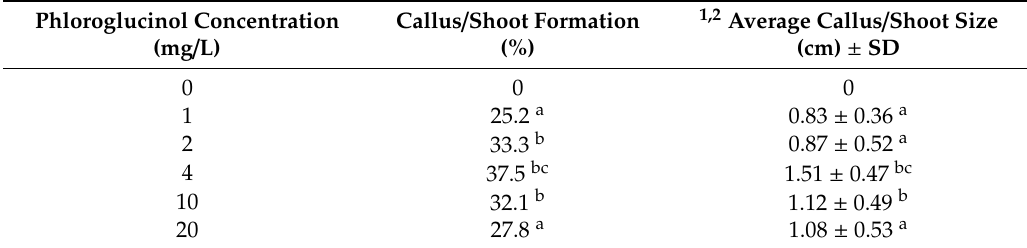
Table 2. Phloroglucinol e ff ects on tissue culture of Ornithogalum dubium.